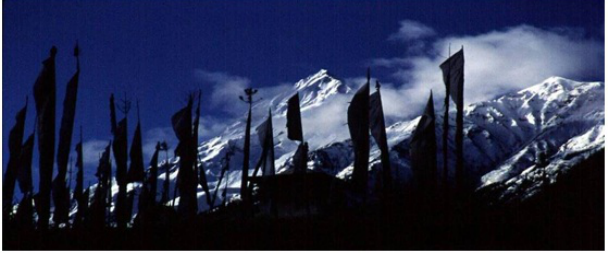
Fig. 2 . Prayer flags in front of Mt. Namjagbarwa. Tibetans have developed the culture of a sacred landscape. Such protecting nature. (Photo by Lu Zhi)